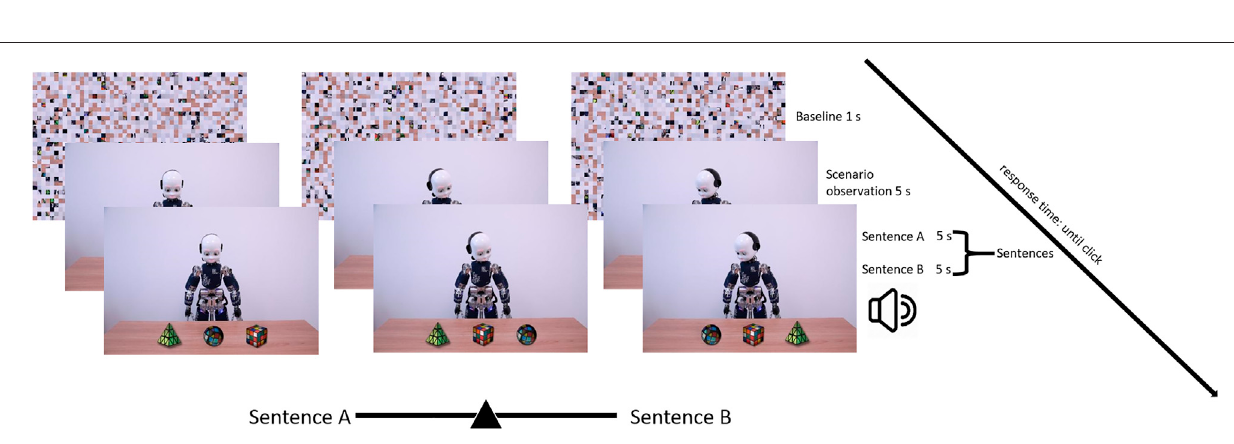
FIGURE 1 | Exempli fi cation of the IST items with exempli fi cation of Sentence A and Sentence B (Marchesi et al., 2019).